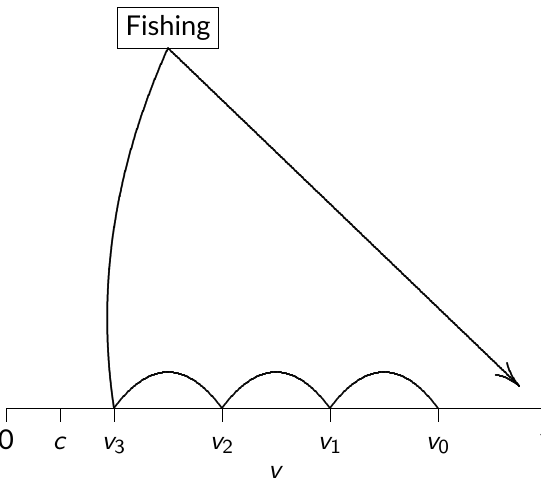
Figure 3 – Dynamics with pure